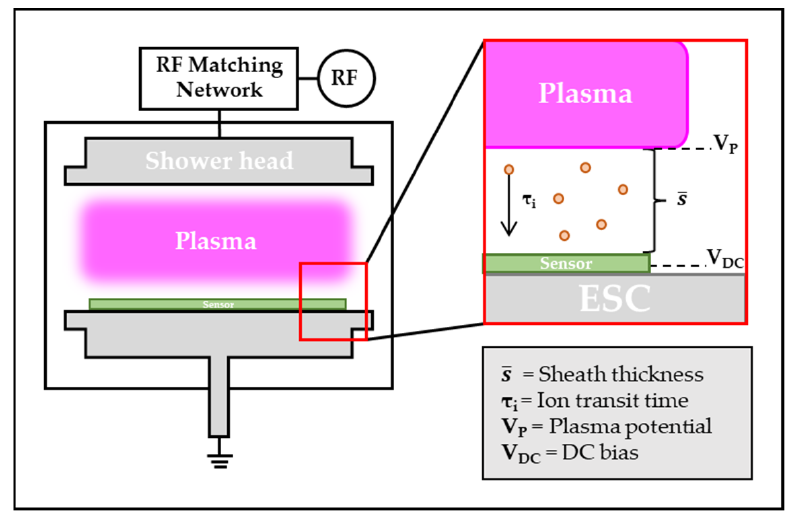
Figure 1. Components of plasma for calculating ion energy.